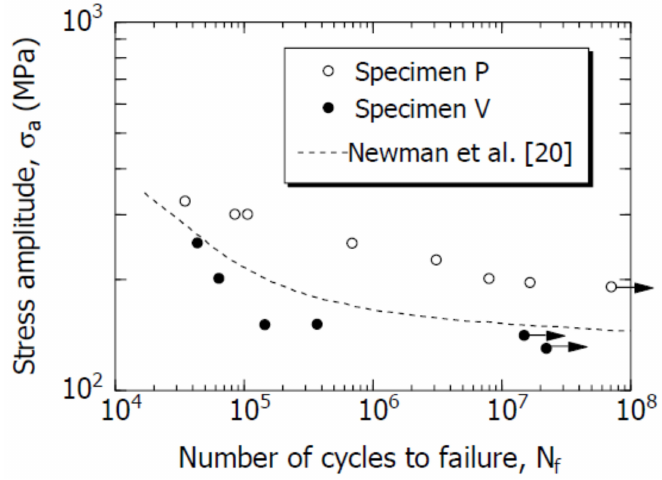
Figure 4. S–N curves of specimens P and V based on laboratory